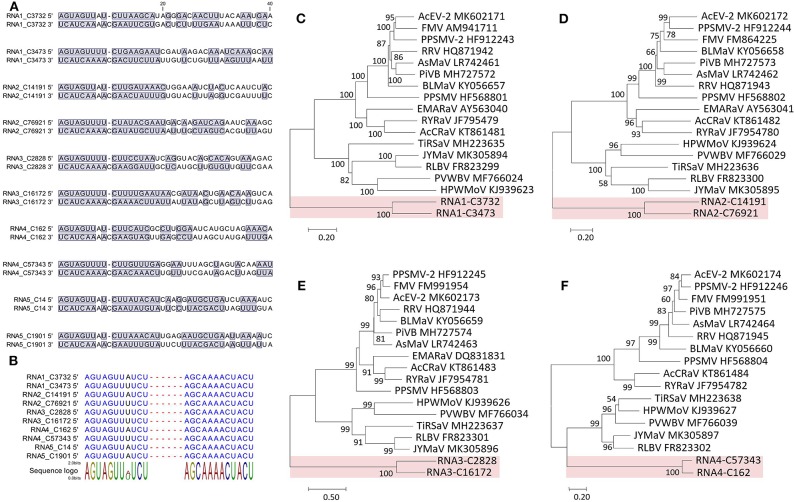
Sequence comparison of the 5′ and 3′ genomic ends of Camellia chlorotic ringspot viruses (CaCRSVs, the fimoviruses) and the complementary nucleotides are indicated with a blue background (A). Multiple sequence alignment of both genomic termini of viral RNAs of CaCRSVs, and the identical nucleotides are displayed in blue (B). Evolutionary analysis of CaCRSVs and representative emaraviruses based on amino acid sequences of RdRp (C), GP (D), NP (E), and MP (F) genes. The genes of CaCRSVs are indicated by the red background. Bootstrap values (1,000 replications) below 50% are not shown.